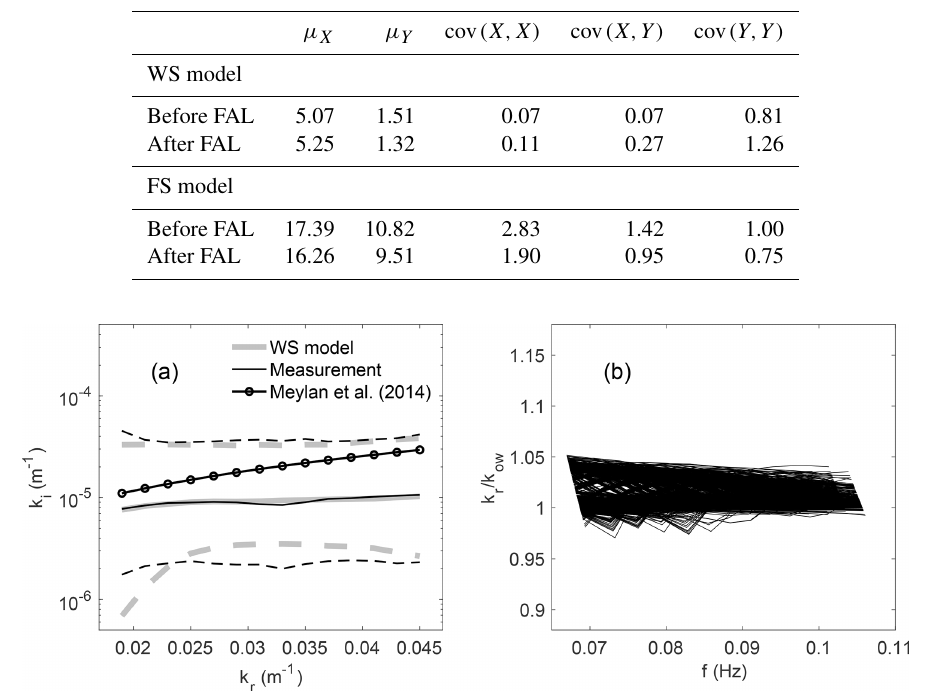
Table 1. Statistical features of the clusters of G and ν from the WS model and FS model calibration. The mean ( µ) and covariance (cov) of X = log 10 G and Y = log 10 ν .